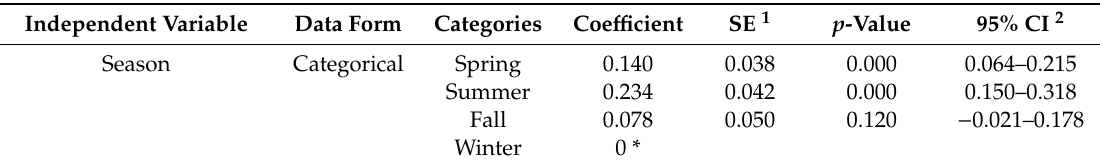
Table 8. Final generalized linear mixed model based on 120 farm visits describing risk factors ( = independent variable) associated with the ratio of esculin-positive streptococci on total mesophilic teat-skin load on herd ( = dependent variable).